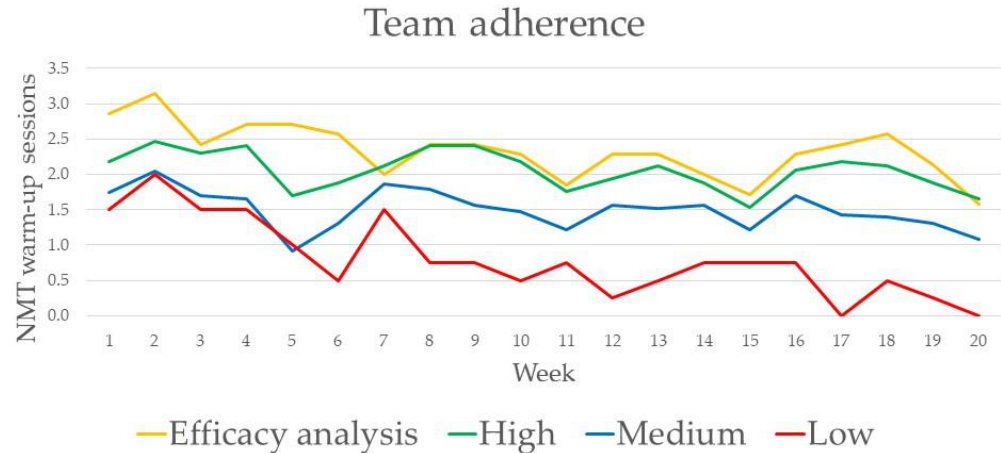
Figure 2. Trend in the adherence to a neuromuscular training (NMT) warm-up through 20-week follow-up. Each line represents mean weekly NMT warm-up sessions within the group; Number of teams: Efficacy analysis ( n = 7 teams), High ( n = 17), Medium ( n = 23), Low ( n =